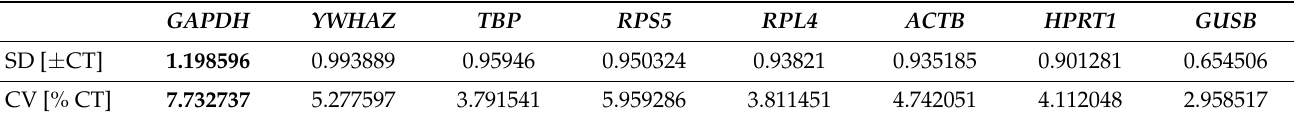
Table 2. Stability of reference gene analyzed by Bestkeeper.